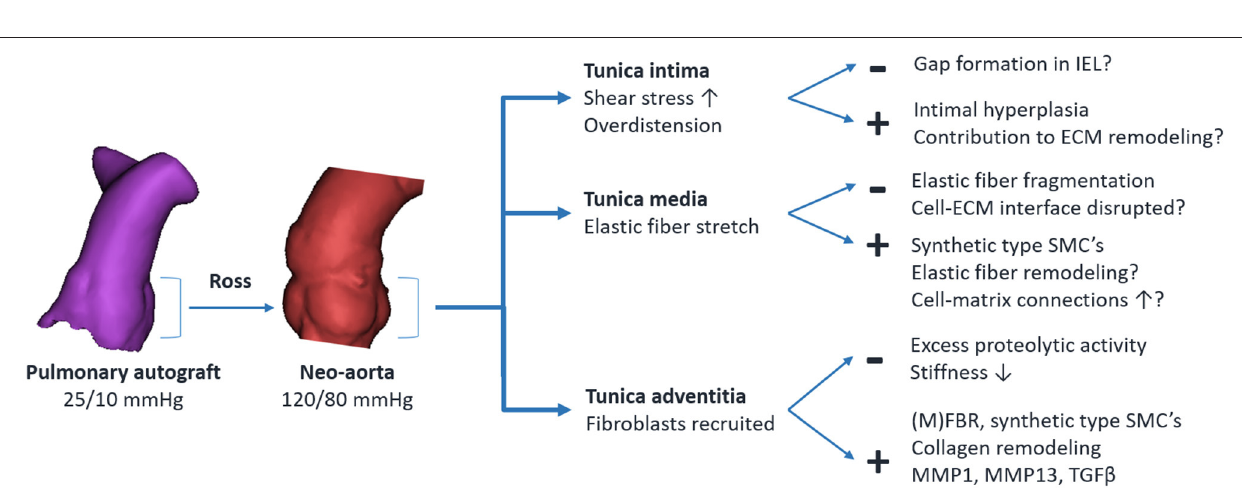
FIGURE 7 | Overview of established and potentially involved mechanisms of pulmonary autograft wall remodeling in the Ross procedure. The + indicates an adaptive response, — indicates maladaptive remodeling. IEL, internal elastic lamina; SMC, vascular smooth muscle cell; ECM, extracellular matrix; MMP, matrix metalloproteinase; TGF β , transforming growth factor β ; (M)FBR,